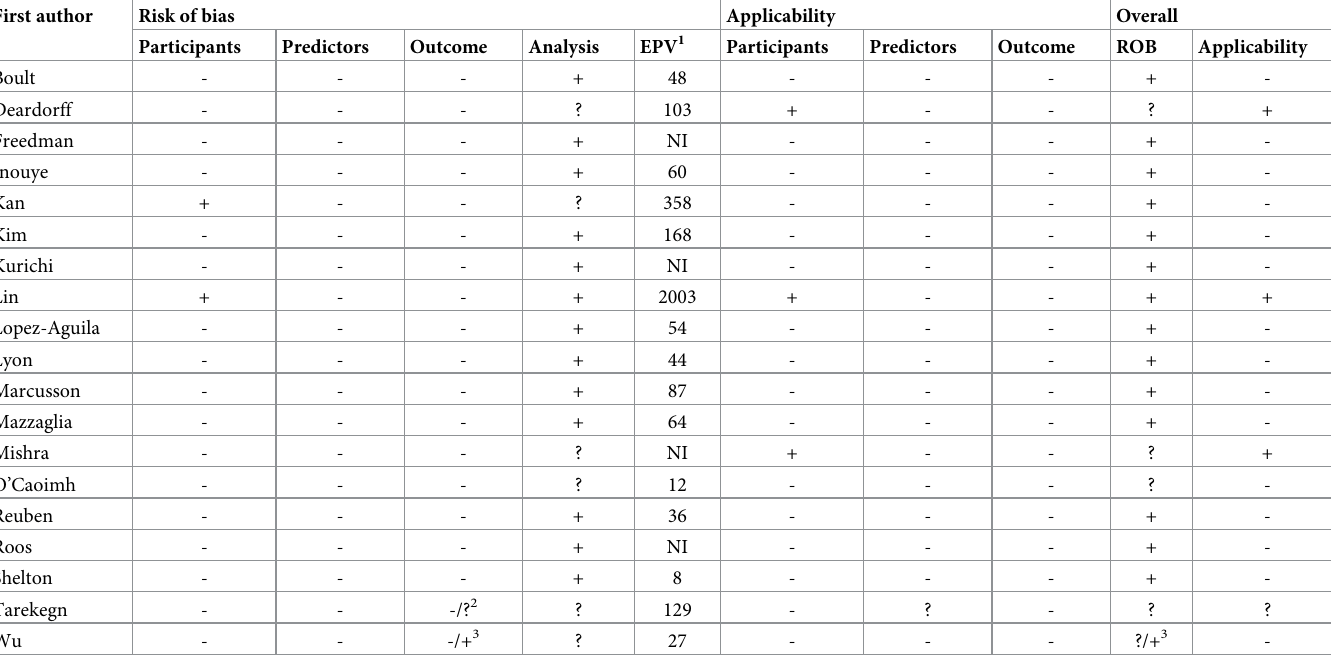
Table 4. Methodological quality assessment of included prediction models according the recommendations of the